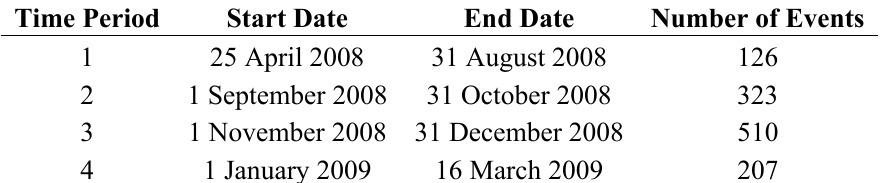
Table 1. Events contained in each time period.